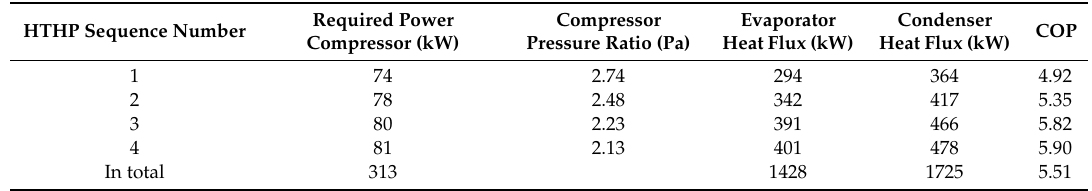
Table 2. Summary of the results of the computer simulation of the series connection of high-temperature heat pumps from Figure